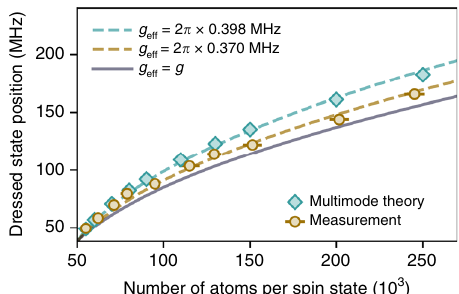
Fig. 3 Scaling of the dressed state frequency with atom number. Position of the upper dressed state as a function of atom number in each spin state for a spin-balanced gas, with Δ c > 0 and Δ a = 0. Orange circles show experimental data and light blue diamonds are obtained from the ab initio theory calculation accounting for all the high-order cavity modes. The lines describe an analytical model with two atomic states and the TEM 00 cavity mode only. The dashed lines are fi ts of both experimental data (orange) and theory calculation (light blue) with g eff as a free parameter (see text). The purple solid line is the expected scaling for g eff = g = 2 π × 0.339 MHz. Error bars are given by the statistical fl uctuations over 10